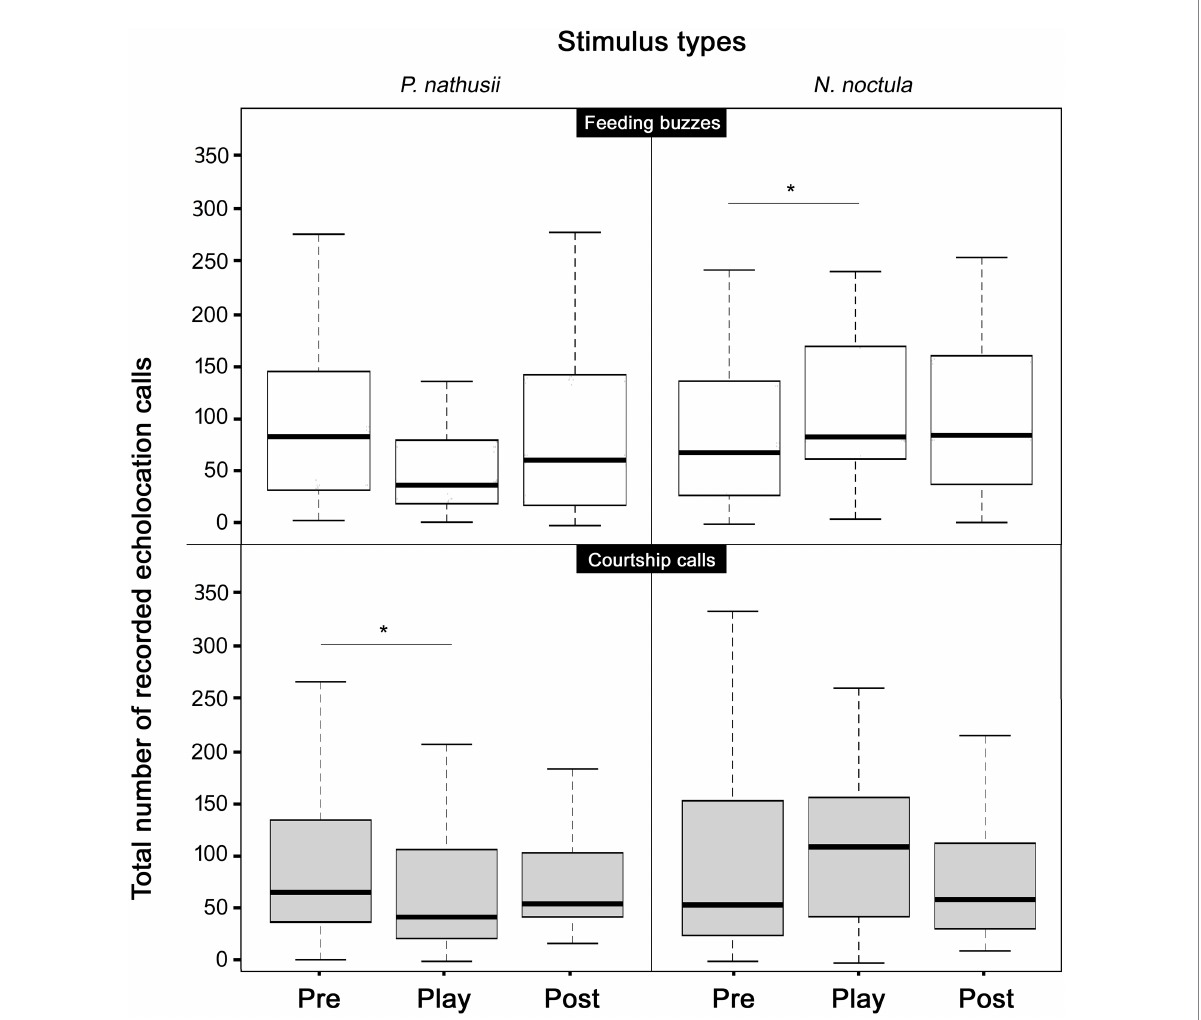
FIGURE 3 Vocal responses of Nathusius’ bats ( P. nathusii ) prior, during and after the playback of broadcasted stimulus types, i.e., feeding buzzes and courtship calls of their own (left graphs) and a heterospecific species ( N. noctula , right graphs). Solid black lines in the center of boxes represent the median, the borders of boxes are 25 and 75 percentiles; whiskers represent the 5 and 95 percentiles. Note, that no changes of acoustic activity levels, and decreases thereof respectively, suggest that the majority of bats passed the speaker location quickly, i.e., without a reduction of their migration speed. In result, the majority of bats will have experienced only a single playback phase. Significant differences between playback periods are indicated by a line associated with an asterisk (* = p <